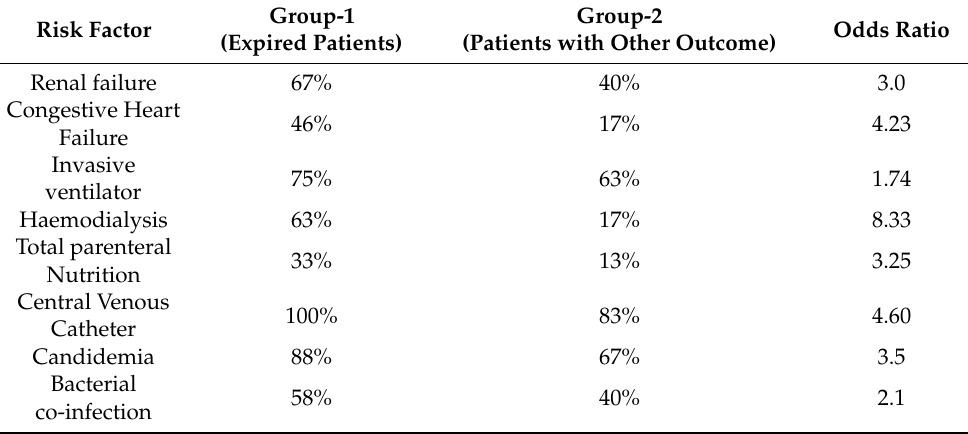
Table 4. Analysis to determine the risk factors for mortality among C. auris cases.